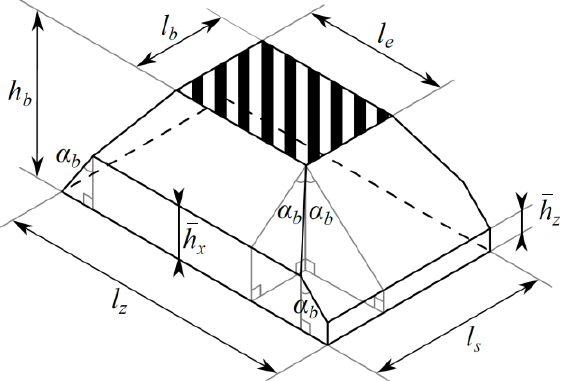
Figure 9. Geometry of the stress cone with superposition in both directions.